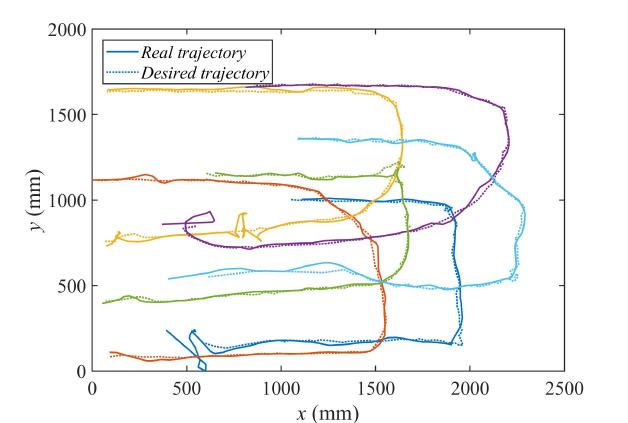
Figure 21. X-Y representation of the consecutive goal positions and the real trajectories of the